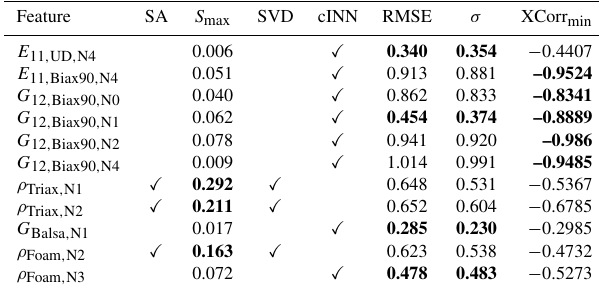
Table 6. Feature selection discrepancies between both methods – sensitivity analysis (SA) and the cINN-based approach – and their corresponding metrics. All values depicted in bold meet their corre- sponding threshold and are thus selected by the respective